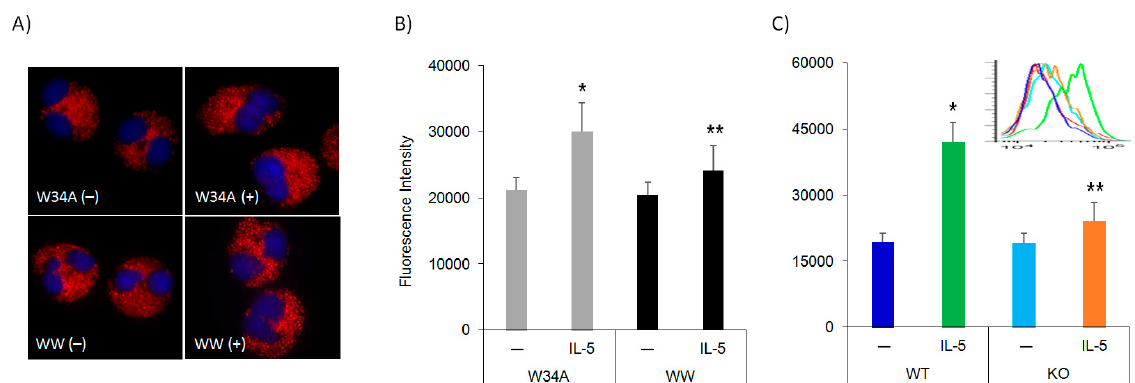
Figure 2. IL-5 induction of F-actin polymerization is Pin1 dependent. ( A ) Human peripheral blood Eos were starved and incubated with Pin1 inhibitor (TAT-WW, 100 nM) or control peptides (TAT-W34A) for 1 h before treatment with hIL-5 (50 ng/mL) for 10 min. Cytospun cells were stained with phalloidin before imaging. ( B ) Fluorescent intensity of cells from ( A ) were measured by flow cytometry. ( C ) BM-derived mouse Eos were starved (3 h) before treatment with mIL-5 (50 ng/mL) for 10 min. Cells were stained with phalloidin and the intensity was measured using flow cytometry. Data are from three independent experiments. * p < 0.05 between untreated (–) and IL-5 in W34A-treated cells, ** p < 0.05 between IL-5 treatments.